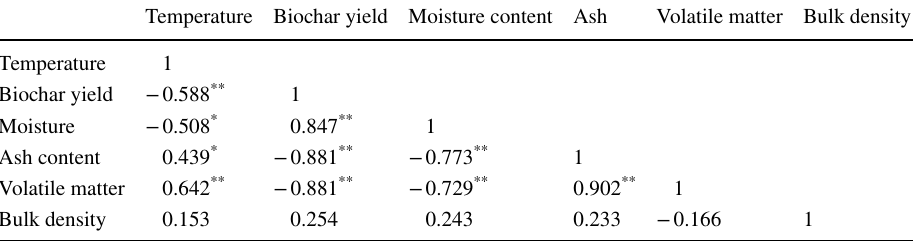
*, **Correlation is significant at the 0.05, 0.01